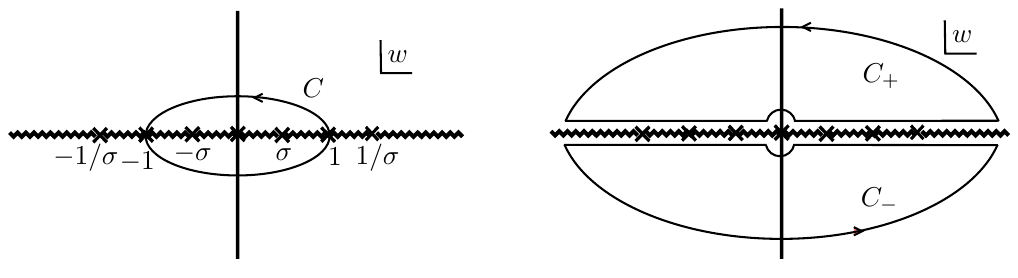
Figure 5 . The w -plane contours C and C (cid:6) in the CFT case. The singularities at w = (cid:6) 1 are integrable and come only from the measure factor j z (cid:0) (cid:22) z j d (cid:0) 2 . The branch points at w = (cid:6) (cid:27) and w = (cid:6) 1 =(cid:27) pose no problems, but the arcs at w = 0 and w ! 1 correspond to the Regge limit where the integrand should vanish at large positive